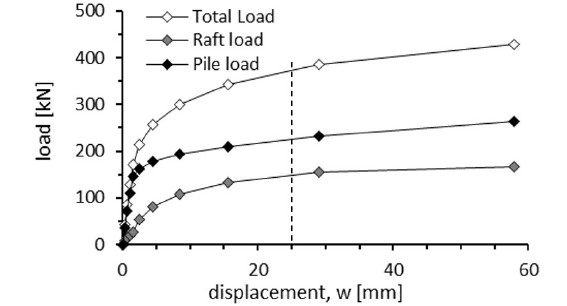
Figure 20. Load-settlement curves for case 13 - L=6m; t=0.1m